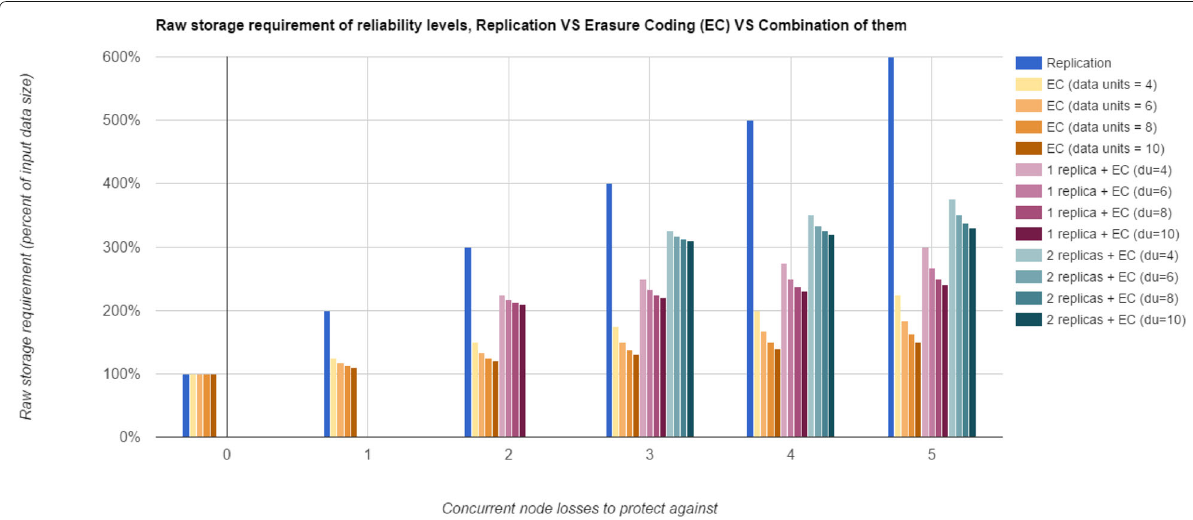
Fig. 5 Secure KVS: Comparing the raw storage requirements of different data protection policies, namely, replication, erasure coding and hybrid policies